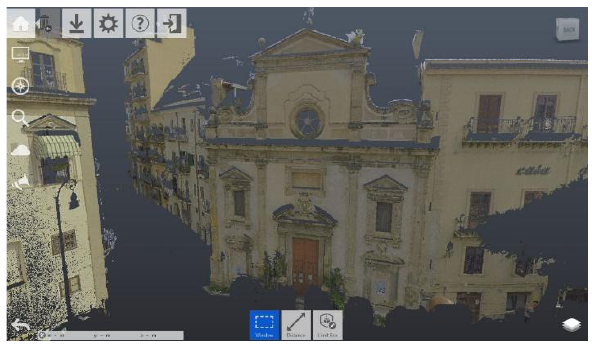
Figure 6. Point cloud of Church of San Sebastiano